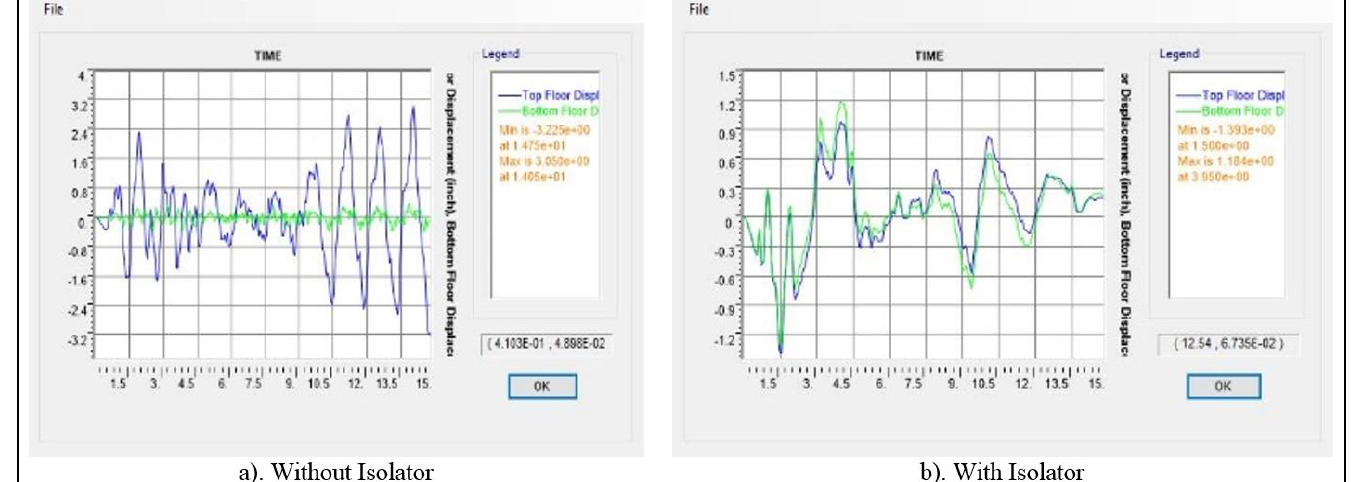
Figure 10: Top and bottom displacement vs time curve (15